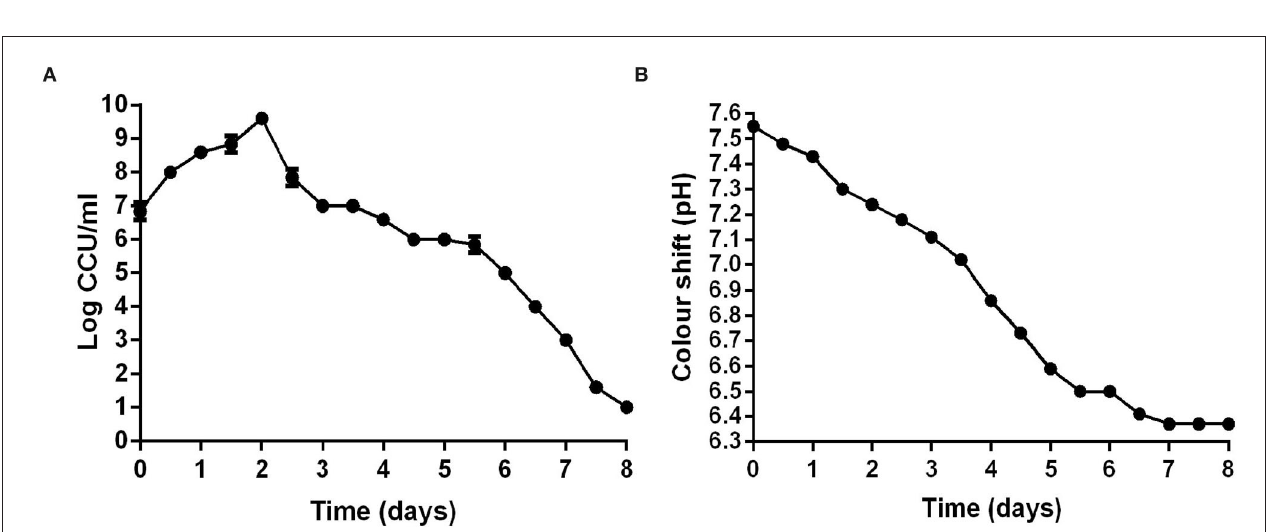
FIGURE 3 | CCU of M. hyopneumoniae and pH of corresponding the modified Friis broth from day 0 to day 8. (A) CCU of M. hyopneumoniae was recorded every 12h. (B) pH of corresponding the modified Friis broth was measured every 12h. The growth curve of three repeating experiments were